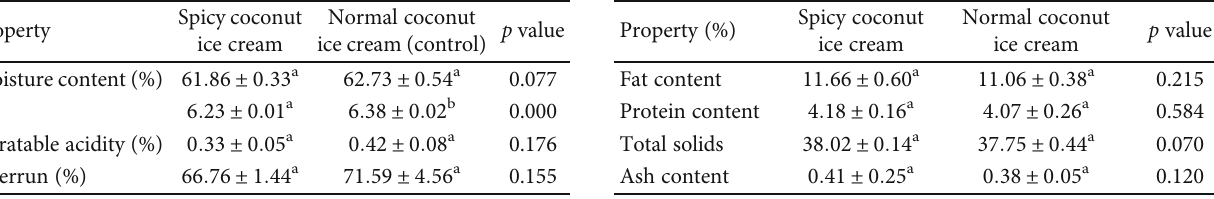
Table 2: Comparison of chemical properties of spicy coconut ice cream with normal coconut ice